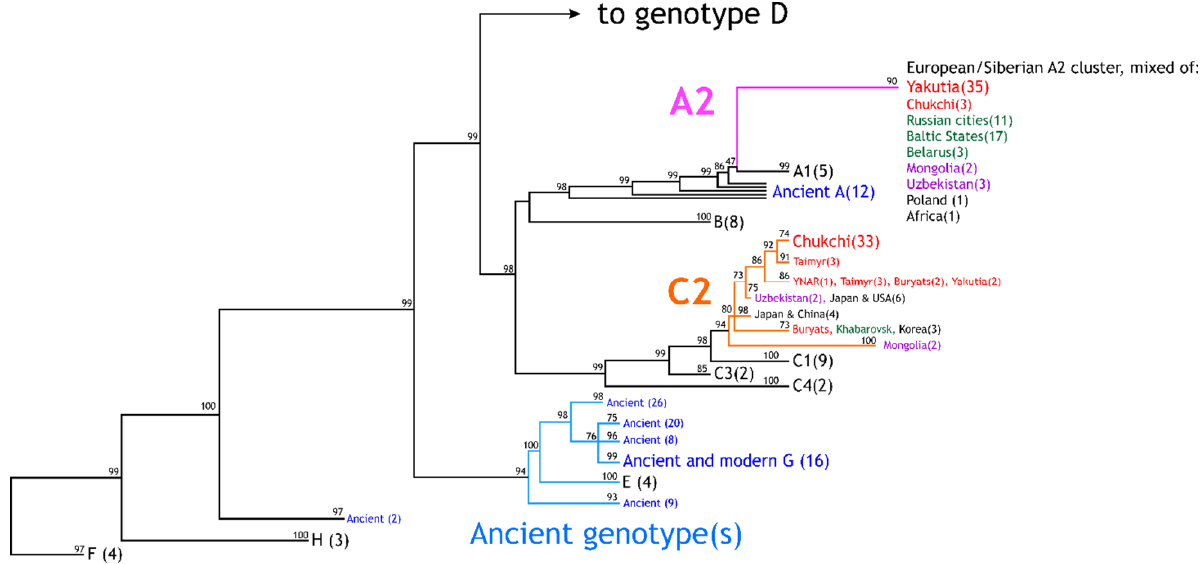
Figure 2. Schematic topology of the constructed phylogenetic tree (genotypes D, A–C, E–H). Clusters and strains are marked in: red: Siberian natives; green: urban populations of Russia, Belarus, and the Baltic States (“Russian population”); violet: Central Asian republics and Mongolia; blue: ancient samples from [31]. Strain numbers in the clusters are shown in brackets. Supporting indices, which were calculated using an aLRT-SH-like procedure (see Section 2), are shown near the corresponding clusters and branches. For a detailed tree of all 1053 samples, see Figure S1 in the Supplementary Materials. Table 2. Prevalence of the HBV subgenotypes and HBsAg subtypes in the studied groups. The most prevalent variants in each group are marked by grey